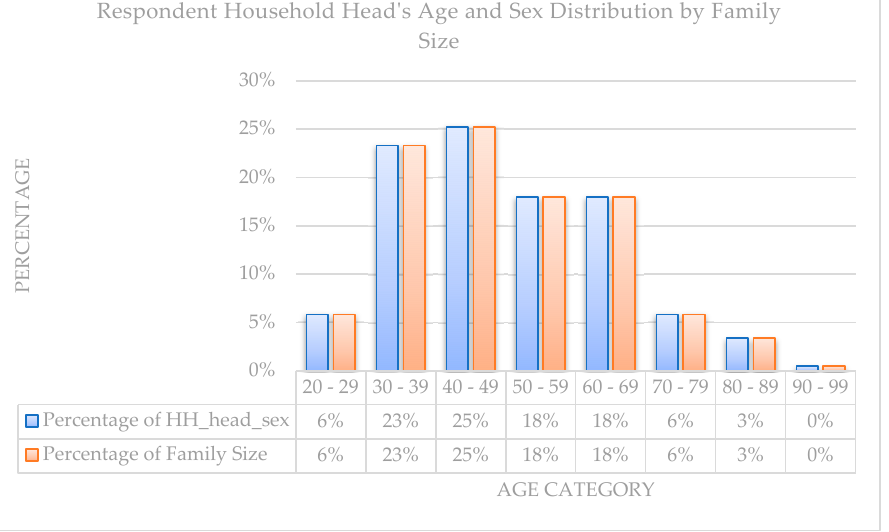
Figure 3. Respondent household’s age and sex distribution with family size. Source: authors’ compilation from household survey.